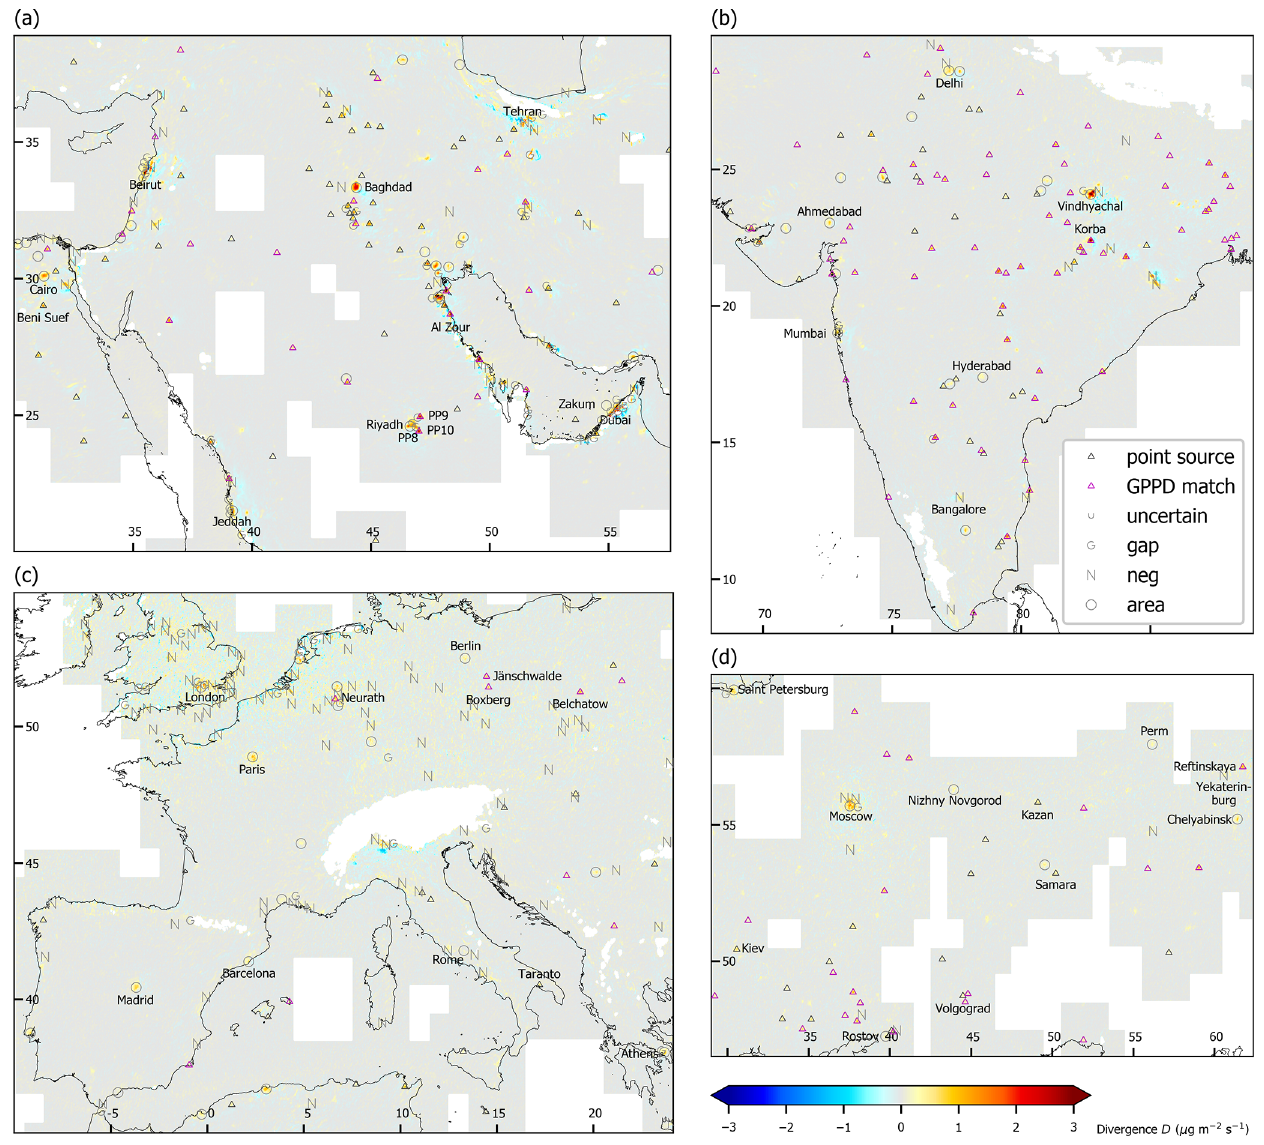
Figure 4. Divergence D (color coded) and point source classification (symbols) for (a) the Middle East, (b) India, (c) Europe, and (d) Ukraine/western Russia. Triangles display the point sources listed in the catalog, where matches to GPPD power plants are indicated in magenta. Respective maps for all regions defined in Table 2 are provided in the Supplement (Figs. S2–S14). Also for sake of clarity, non-point sources are only shown for candidates with D max > 1µgm − 2 s − 1 or the integrated divergence within 30km exceeding 0.1kgs − 1